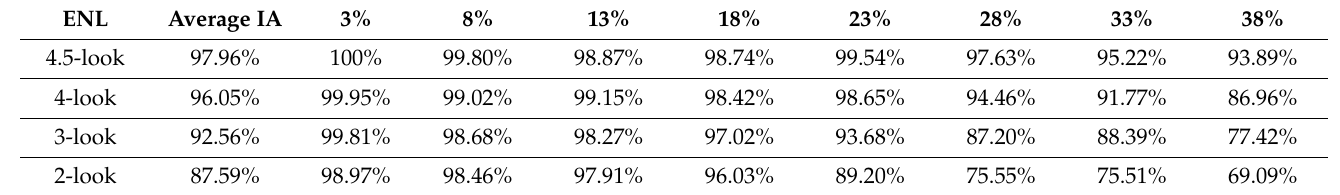
Table 5. Simulated data average IA and IA of dual-channel CNN in different levels of noise.